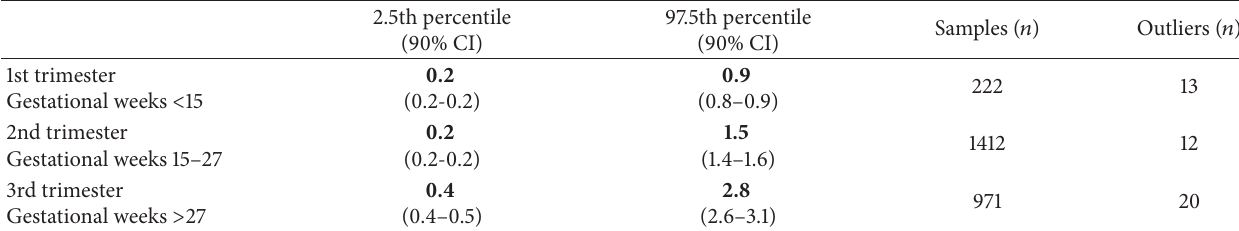
Table 1: Gestational age-specific D-dimer reference intervals.